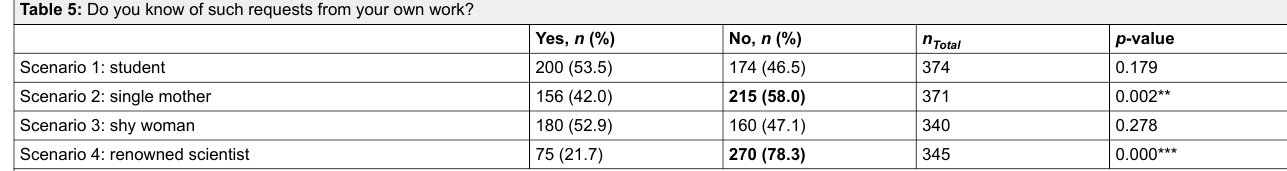
Table 5: Do you know of such requests from your own